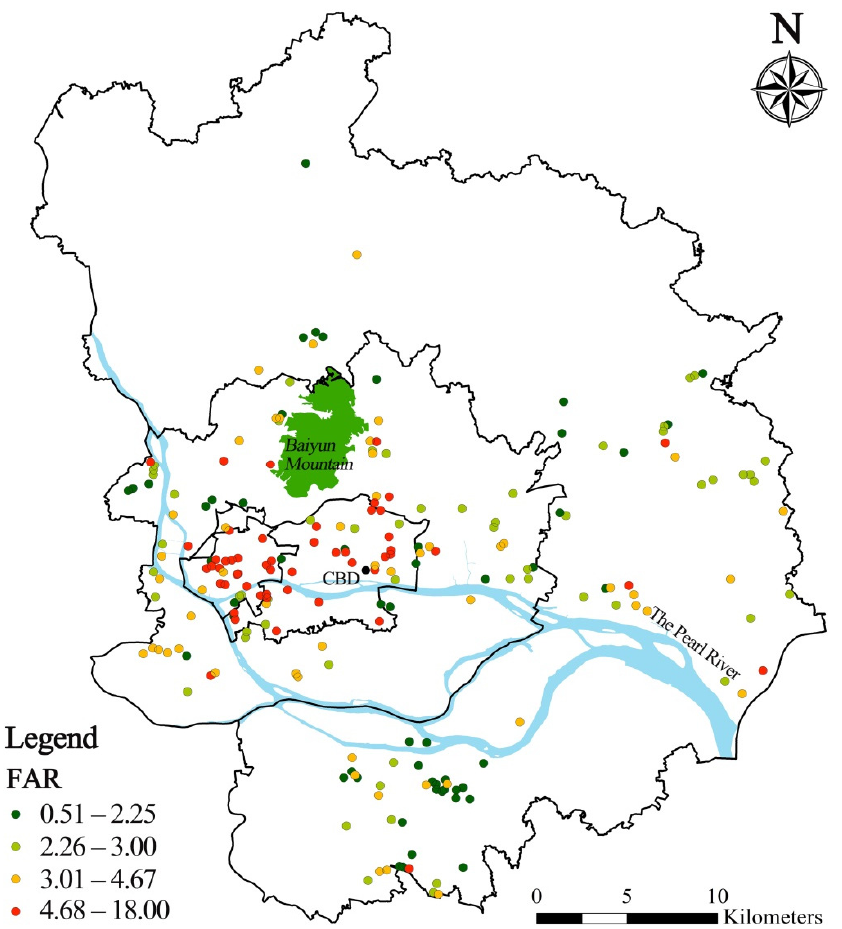
Figure 6. Spatial pattern of FAR of residential quarters.